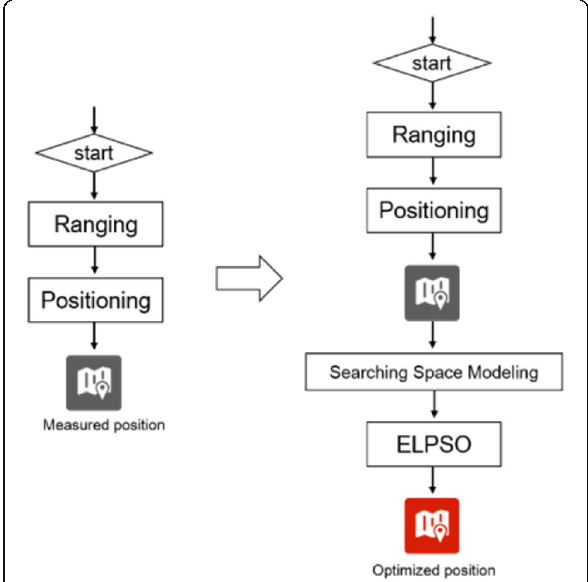
Fig. 1 Comparison of our approach with existing UWB